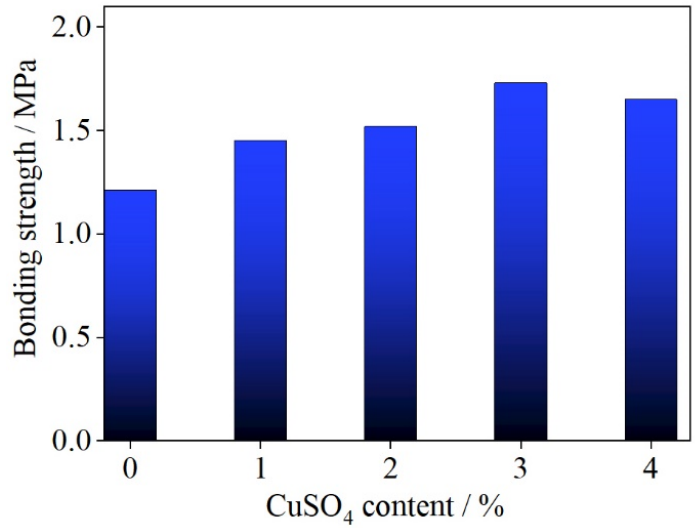
Figure 2. Relationship between copper (II) sulfate content in UF resin adhesive and the bonding strength of plywood.